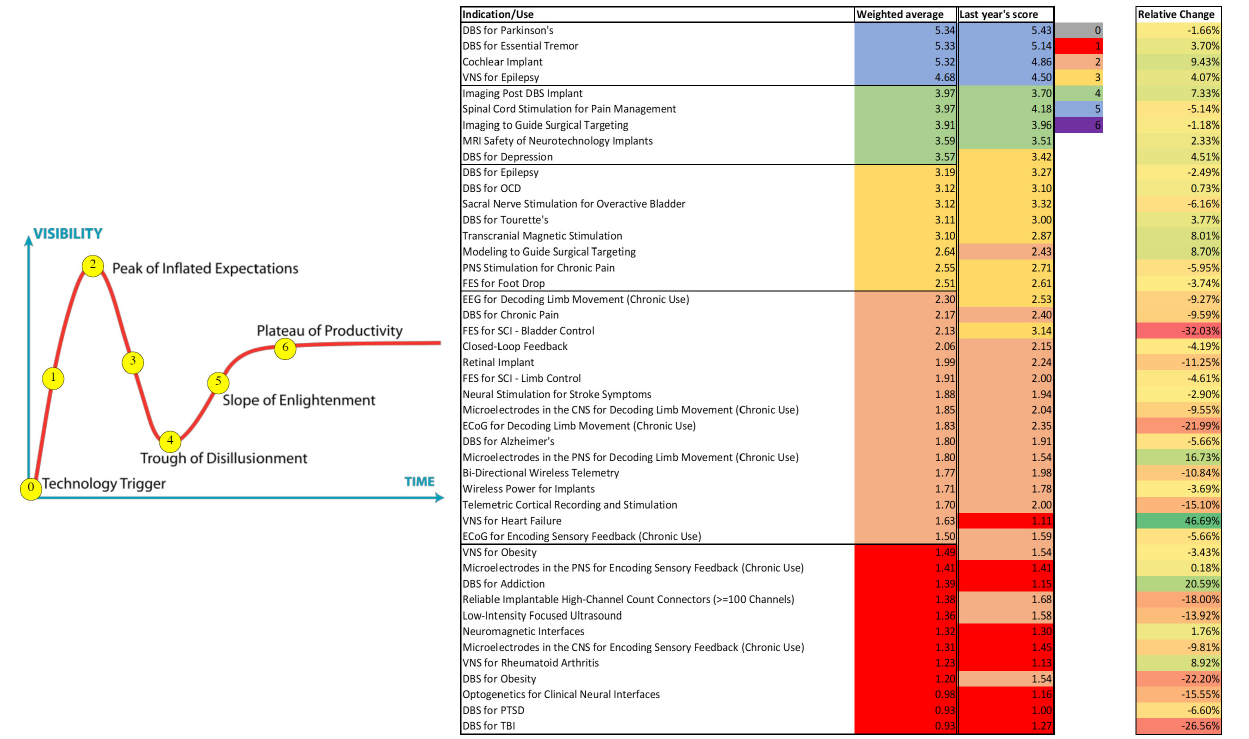
FIGURE 11 | Perspectives and Attitudes Toward DBS. An anonymous 40 question poll was sent online to assess participants’ perspectives and attitudes toward the current and near-term future developments and applications in the DBS field. Sixty six participants